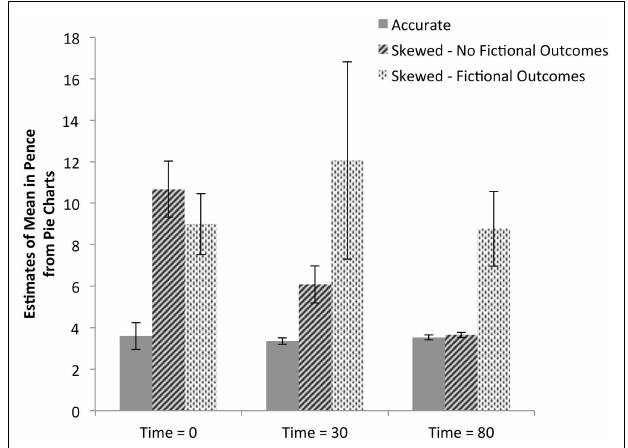
FIGURE 3 | Implied estimates of mean payout across time. Data from participants’ pie charts were used to calculate each participants implied estimate of mean payout. Data shown in solid gray bars are from participants who were shown accurate payout tables including only valid outcomes.The data are split based on whether the participant persisted throughout the game in including the fictional higher-value outcomes of 15, 20, 25, and 100 pence; 8 of 26 participants given skewed payout tables included the fictional outcomes; no participants given accurate payout tables did so. Responses for the left and right machines at each judgment collection time were averaged resulting in one response per participant for each of the three judgment